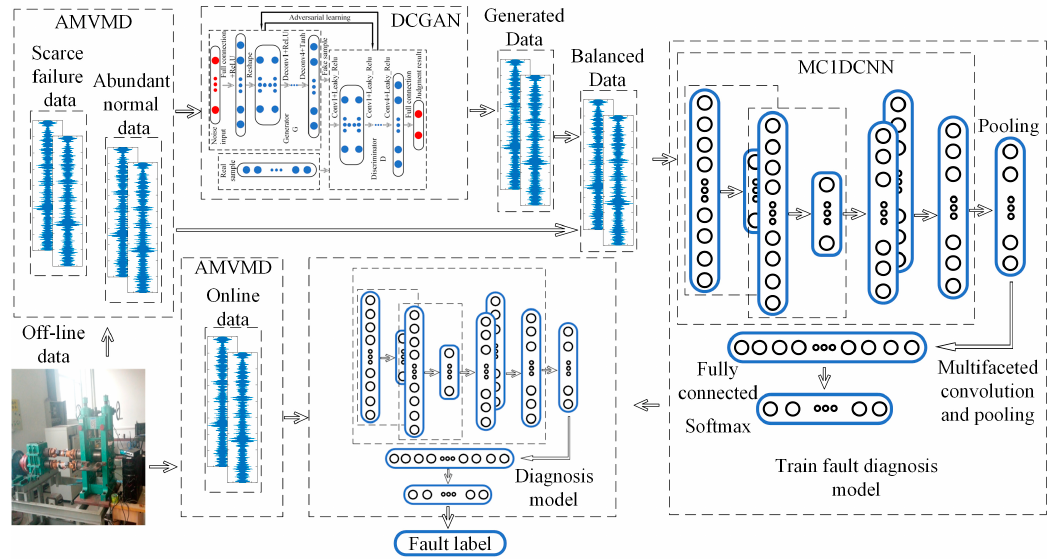
Figure 7. Fault Diagnosis Model.